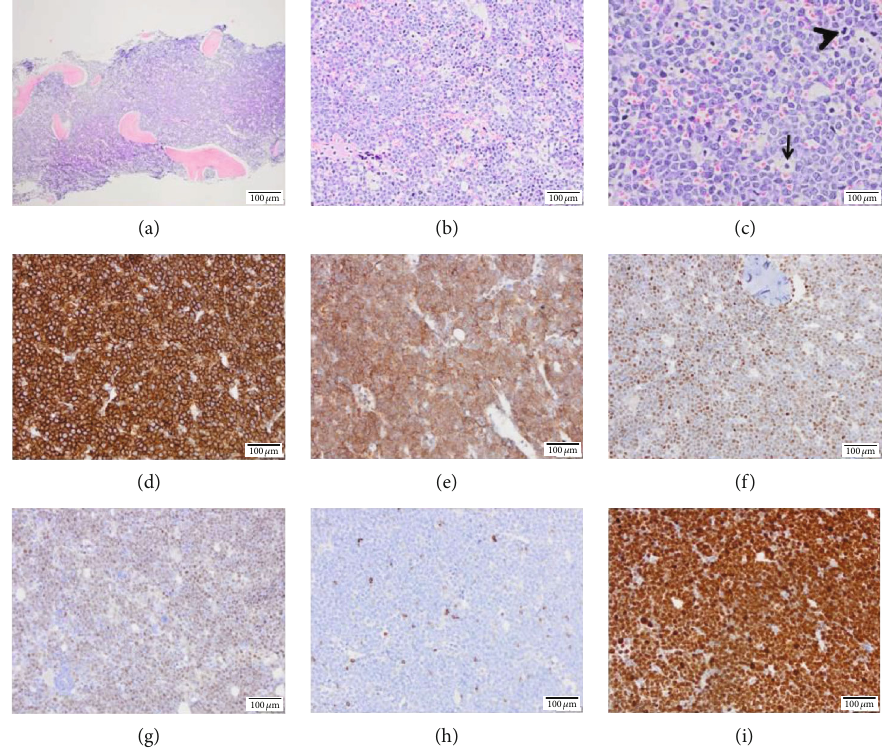
Figure 2: Photographs of bone marrow biopsy with primary Burkitt lymphoma. Low magni fi cation showed a (a) hypercellular bone marrow with (b) monotonous in fi ltration of medium-sized lymphocytes that displayed (c) many mitotic (arrowhead) and apoptotic fi gures (arrow). Immunohistochemical analysis of lymphoma cells showed positivity for (d) CD20, (e) CD10, (f) Bcl-6, and (g) c-myc, while (h) Bcl-2 was negative. (i) Ki67 proliferative rate of tumor cells was nearly